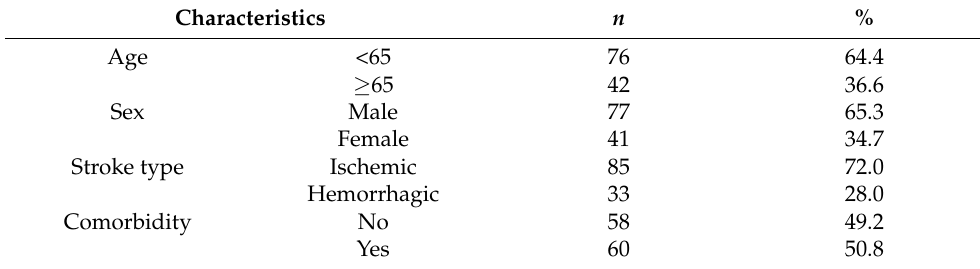
Table 2. Characteristics of stroke patients.